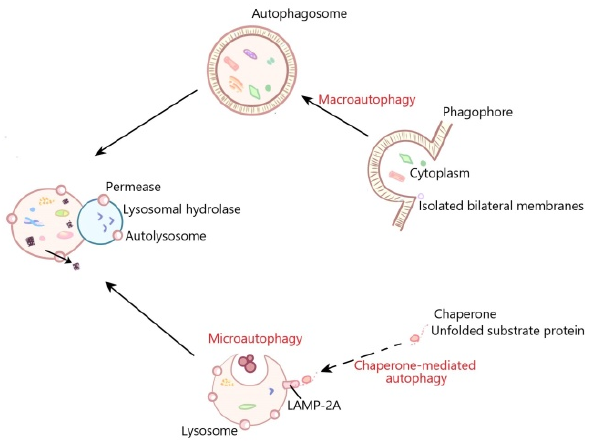
Figure 1. The general processes of macroautophagy, microautophagy and molecular chaperone- mediated autophagy.